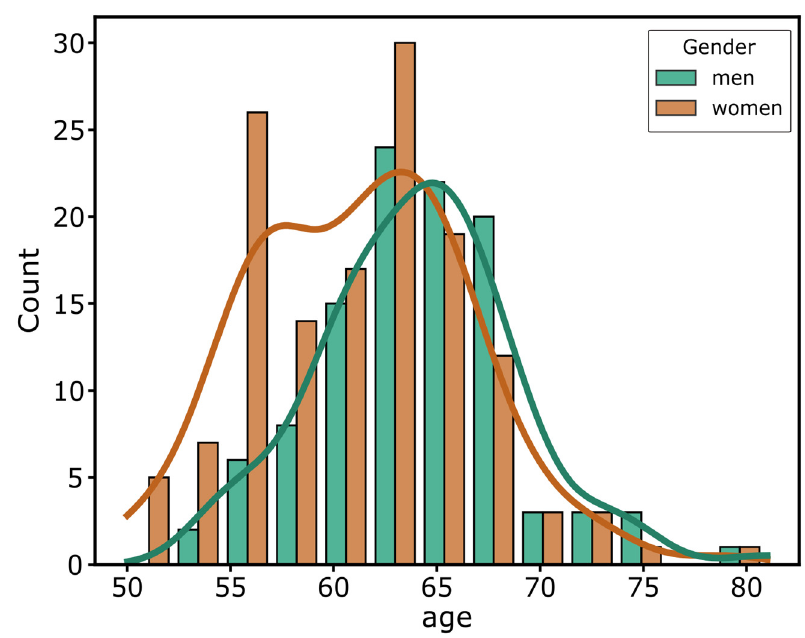
Figure 2. Age distribution of the NFSE sample by gender. Mean ( ± SD ) age 62.5 ( ± 5.23) years. Minimum age = 50, maximum age = 81 years. N = 245, 138 women and 107 men. Table 1. Demographics of participants. Means ± Standard deviations.